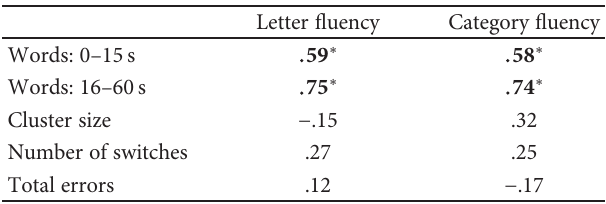
Table 7: Pearson correlations between decline in verbal fl uency and fl uency characteristics after